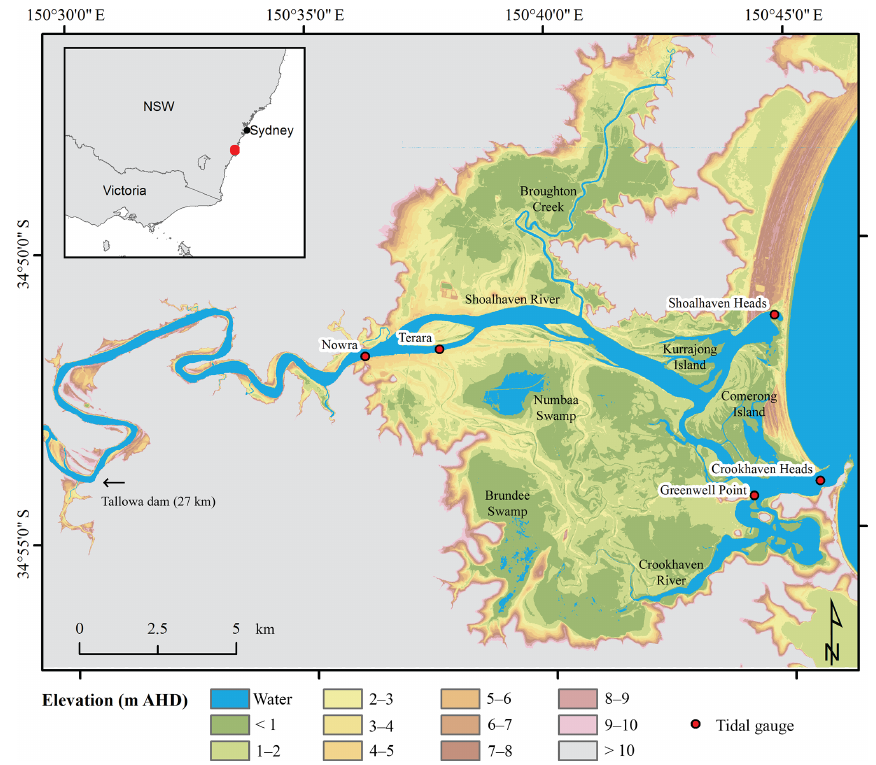
Figure 1. Map showing the lower Shoalhaven River and tidal gauges (red dots). Lidar-derived topographic data of the floodplain is presented in m